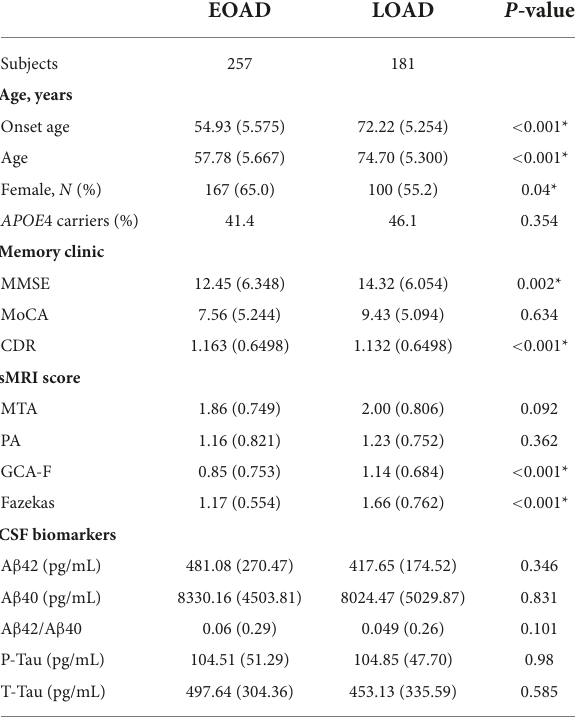
TABLE 6 Characteristics of AD patients according to age at